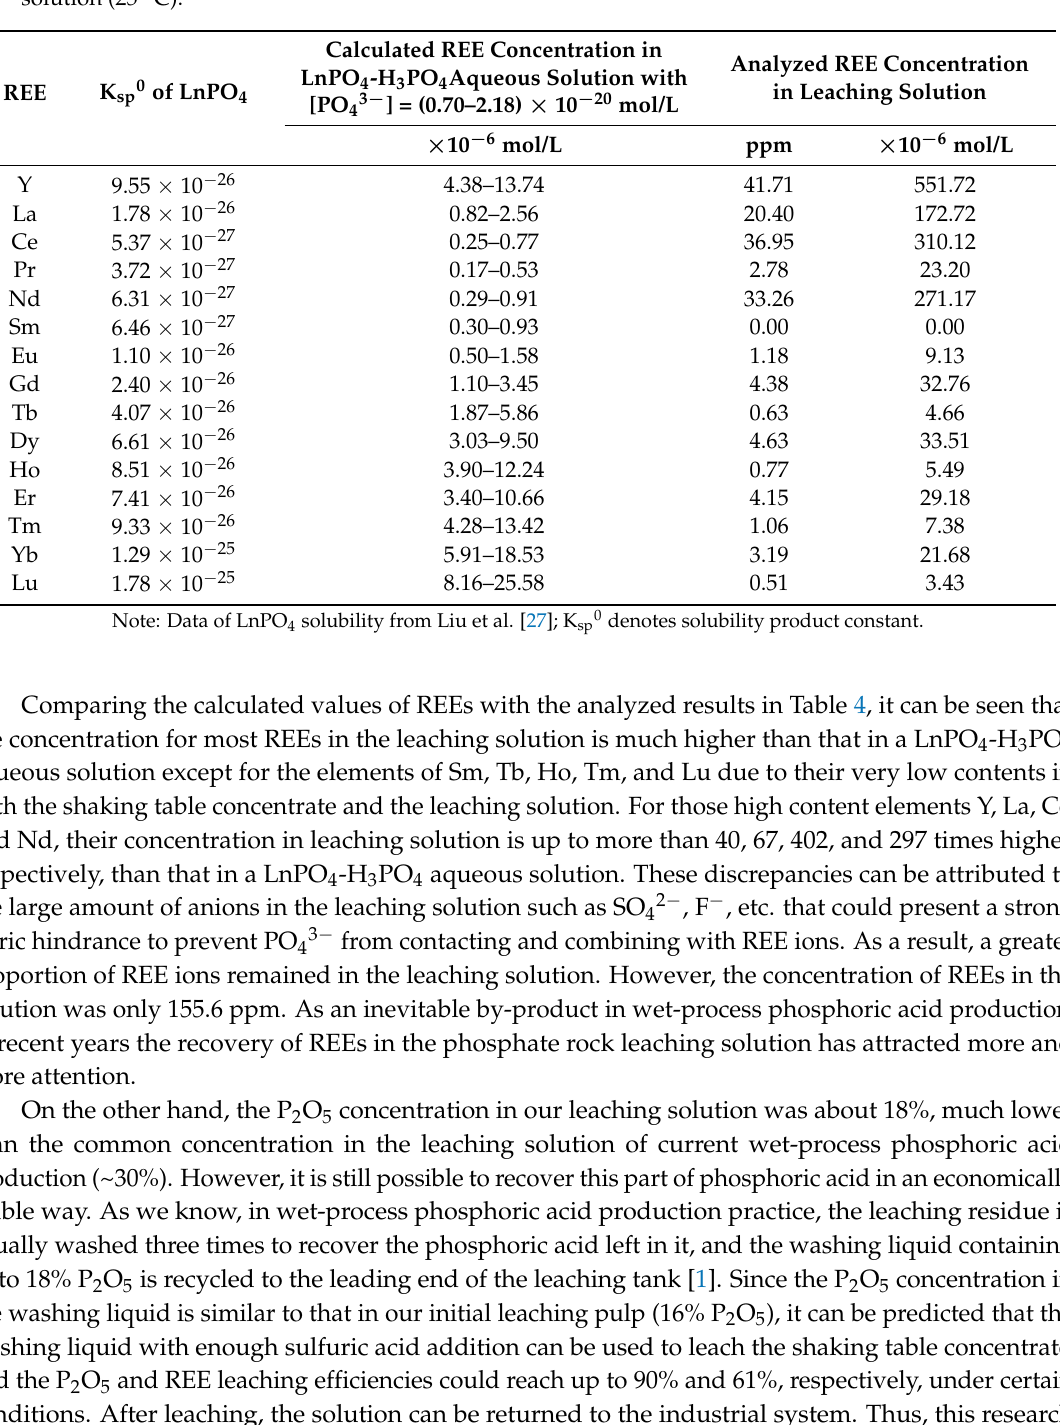
Table 4. Rare earth element (REE) concentration in different dissociation-precipitation equilibrium solution (25 ◦